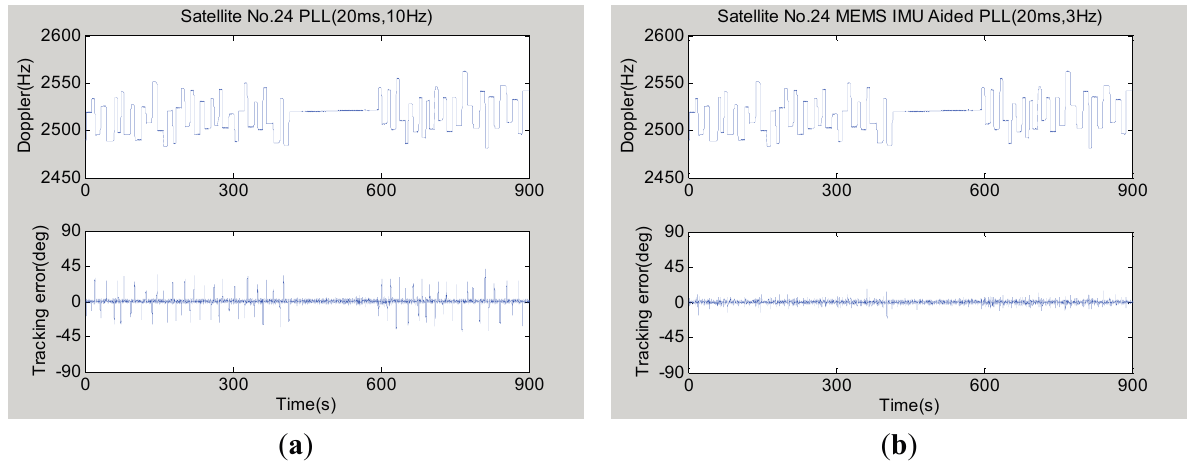
Figure 16. GNSS carrier phase tracking error in the higher dynamic scenario testing based on the simulator. ( a ) Normal PLL (20 ms, 10 Hz); ( b ) MEMS INS-aided PLL (20 ms, 3 Hz).